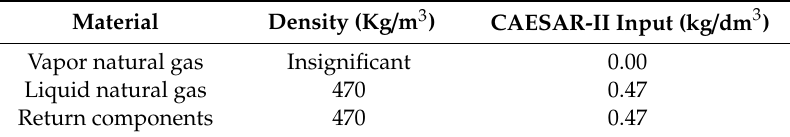
Table 3. Fluid characteristics of pipe.